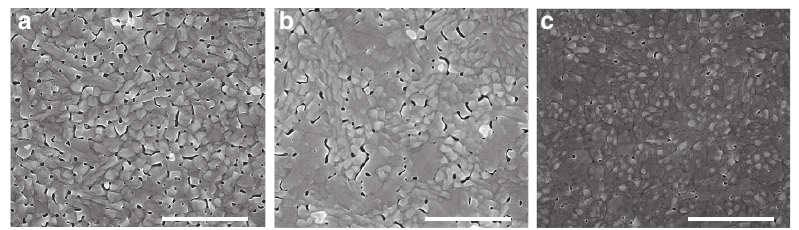
Figure 1 | Morphology of CsPbBr 3 films deposited under different conditions. ( a – c ) Planar SEM images of CsPbBr 3 deposited on ZnO, ZnO/PVP and Cs 0.87 MA 0.13 PbBr 3 on ZnO/PVP, respectively, here PVP is polyvinyl pyrrolidine. The scale bar is 2 m m in all images.